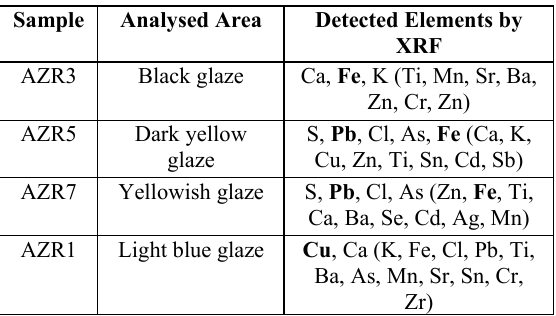
Table 2. Elements detected by X-Ray fluorescence analysis. For each sample, the key element for pigment identification is marked in bold. The minor or trace elements are presented between brackets.